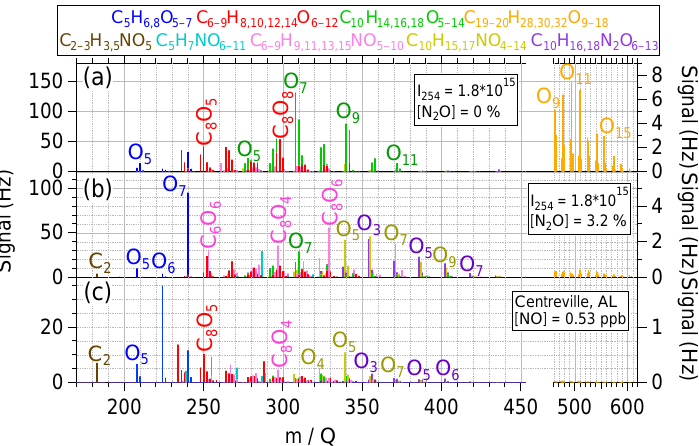
Figure 6. NO − -CIMS mass spectra of α -pinene oxidation products generated in the PAM reactor at [H 2 O] = 0.07%, [O 3 ] = 5ppm, and 3 mean residence time = 80s: (a) I 254 = 1.8 × 10 15 phcm − 2 s − 1 , [N 2 O] = 0%; (b) I 254 = 1.8 × 10 15 phcm − 2 s − 1 , [N 2 O] = 3.2%. (c) NO − CIMS mass spectra of the same compounds detected at the SOAS ground site in Centreville, Alabama, USA during “high-NO” conditions shown in Fig. 4f (note: C 5 H 7 NO 6 − 11 signals in SOAS spectra also contributed from isoprene + OH oxidation products). “C x ” or “O x ” labels indicate number of oxygen atoms in corresponding signals (not including oxygen atoms in nitrate functional